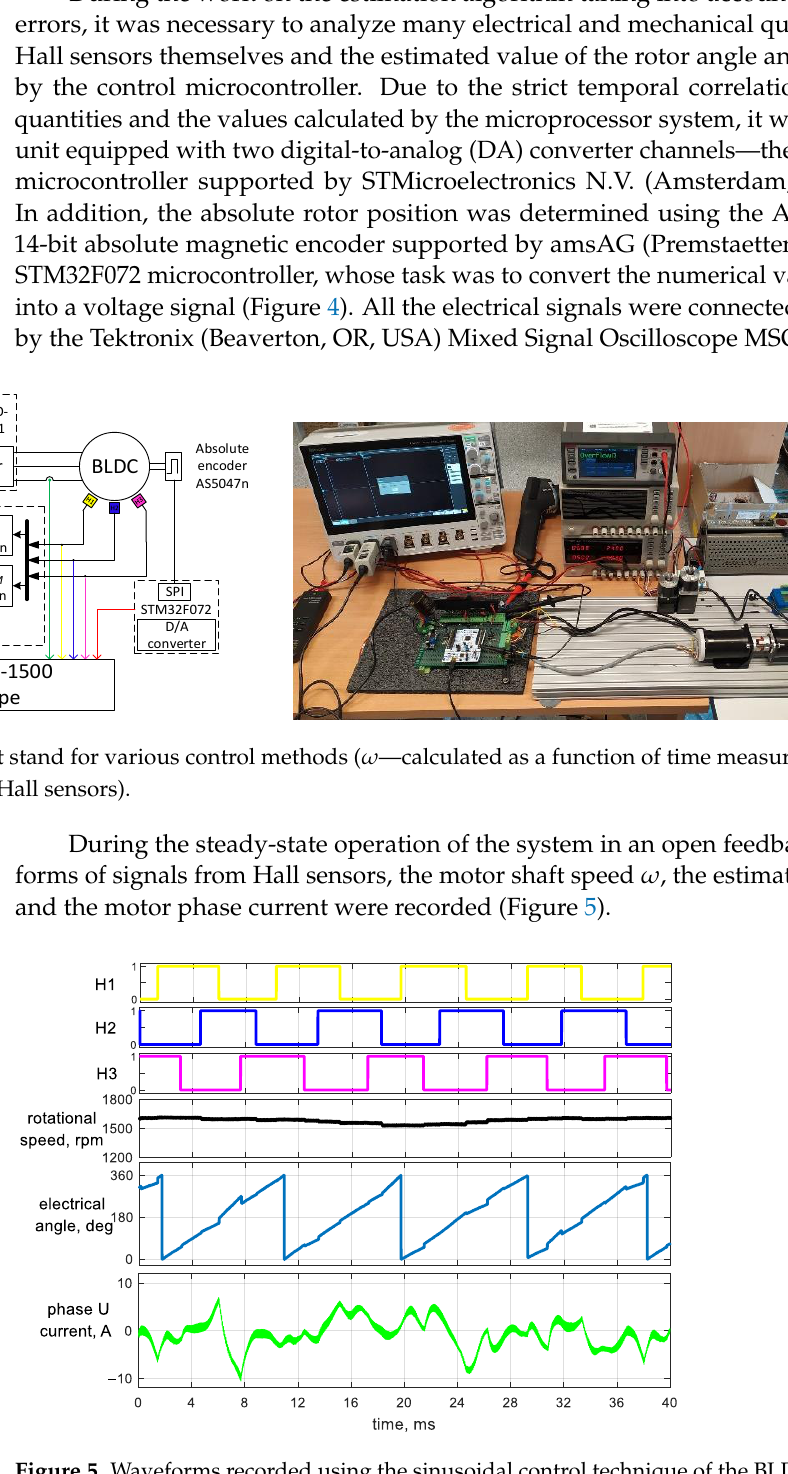
Figure 5. Waveforms recorded using the sinusoidal control technique of the BLDC motor with clas- sic rotor position estimation.